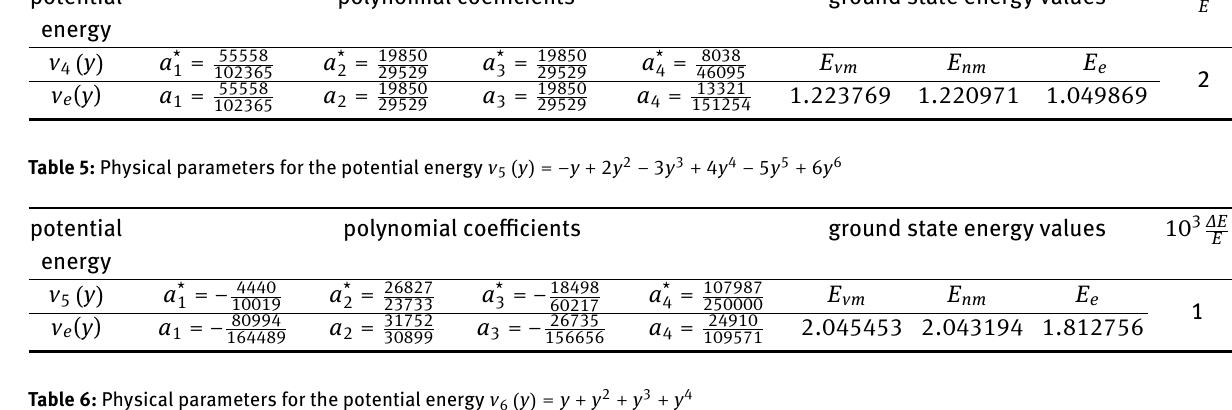
polynomial coeflcients